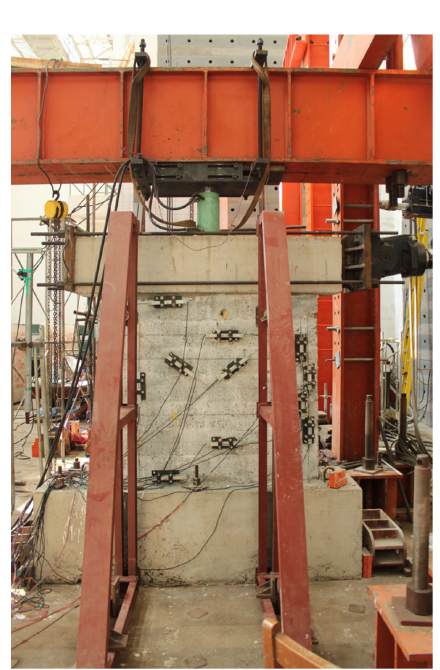
Figure 5. Self ‐ insulating concrete masonry shear wall (SW1) ready for testing. Figure 5. Self-insulating concrete masonry shear wall (SW1) ready for